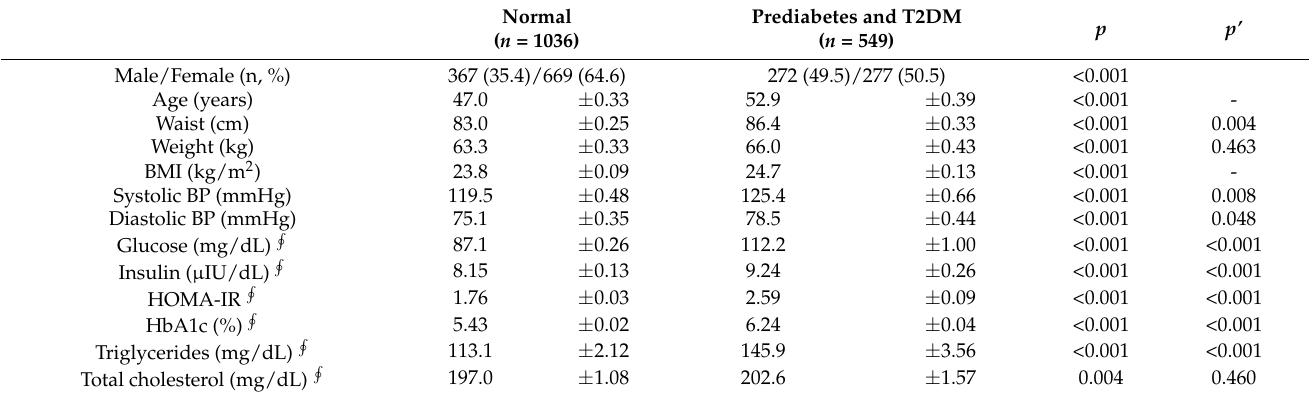
Table 1. Clinical and biochemical characteristics of the normal versus prediabetes and T2DM groups. Normal Prediabetes and T2DM ( n = 1036) ( n =